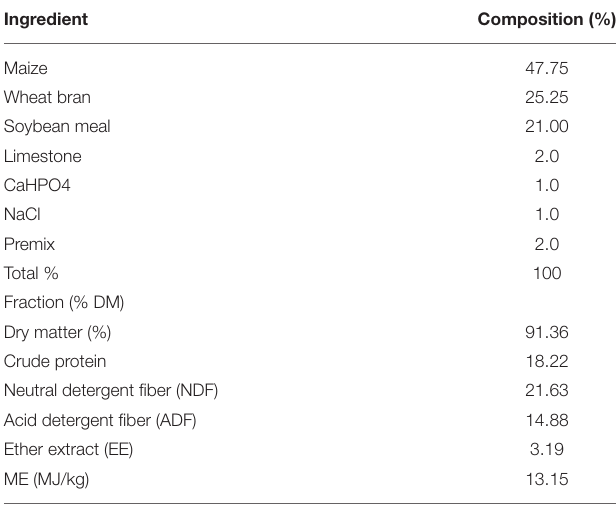
TABLE 1 | Composition of concentrate fed to Simmental